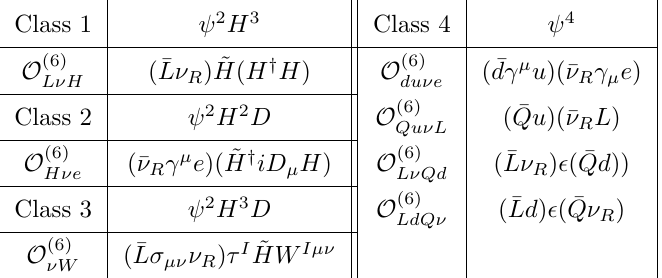
Table 1 . (cid:23) SMEFT dim-6 operators [20] involving one sterile neutrino (cid:12)eld. The (cid:12)rst operators have dimension